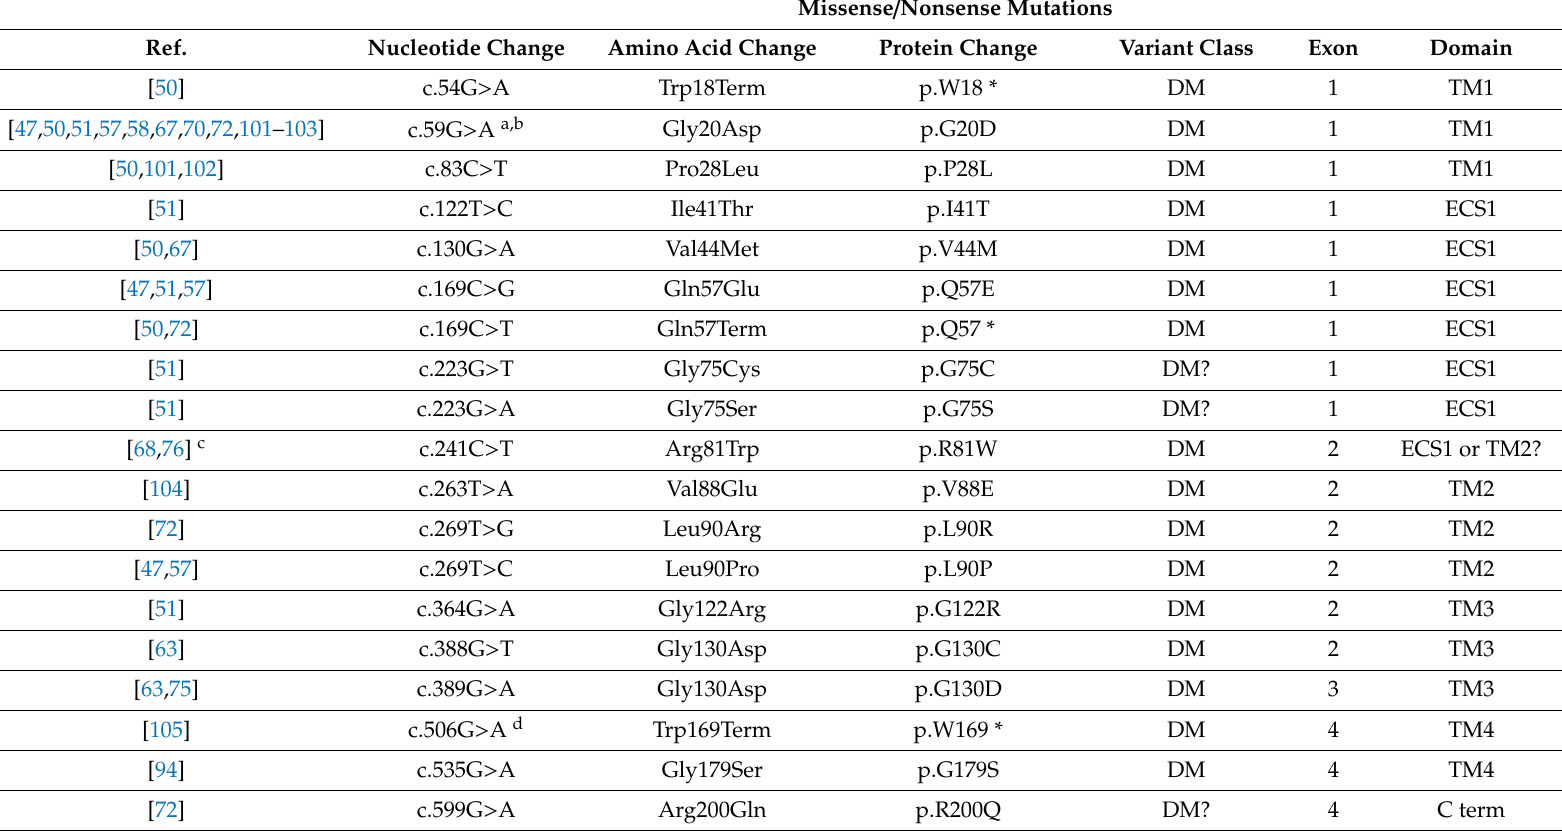
Table 5. CLDN19 disease-causing variants